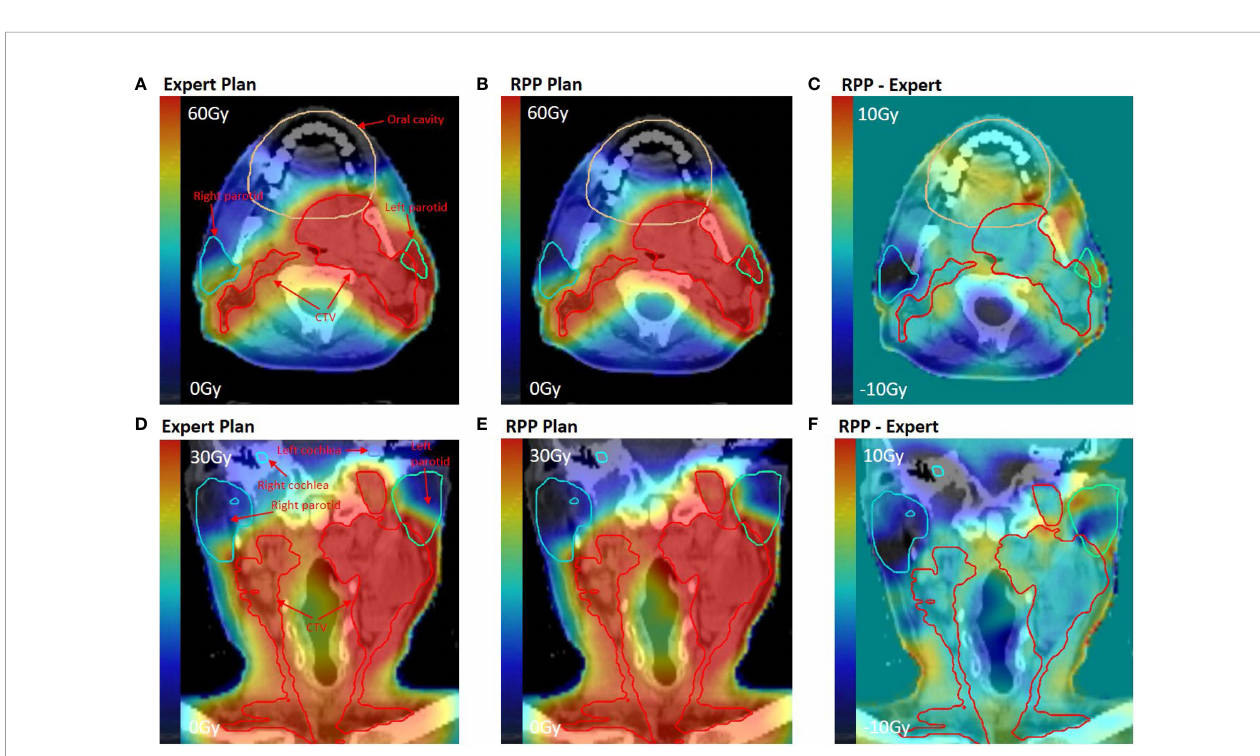
FIGURE 4 | Dose distribution for an example bilateral case in the validation group. (A, D) Dose distribution of the expert plan. (B, E) Dose distribution of the RPP plan. (C, F) Dose difference map between RPP and expert plan. (A – C) On axial plane, while (D – F) on coronal